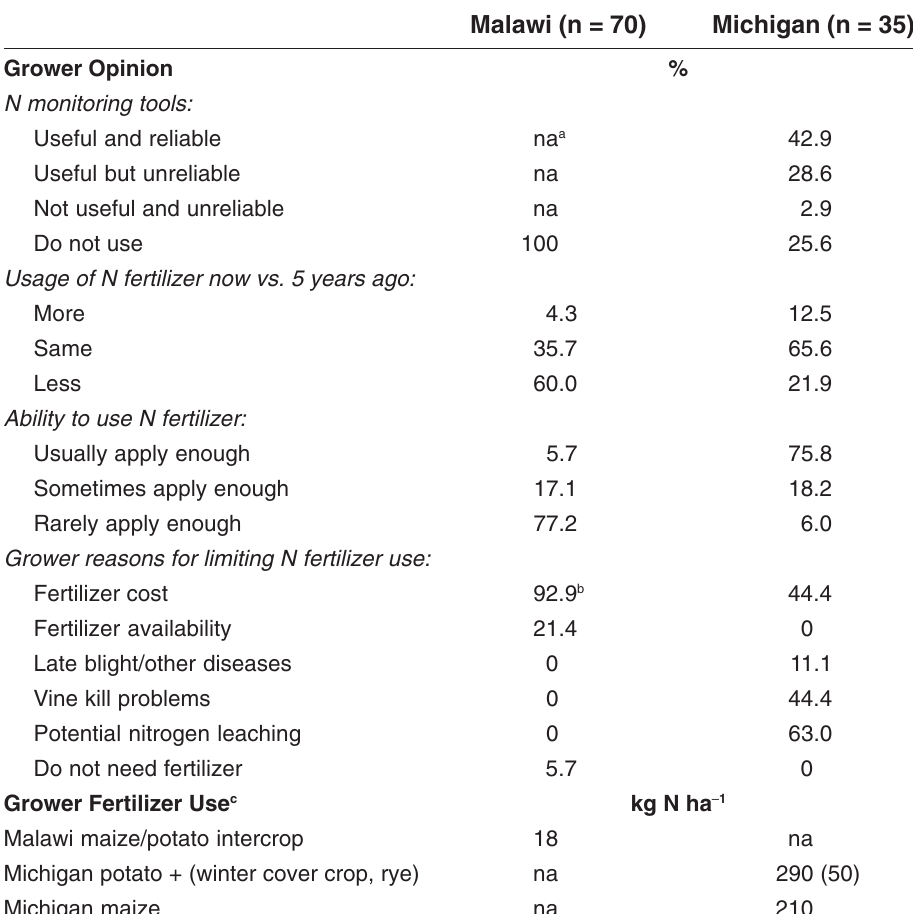
Nitrogen Management Survey Response Data